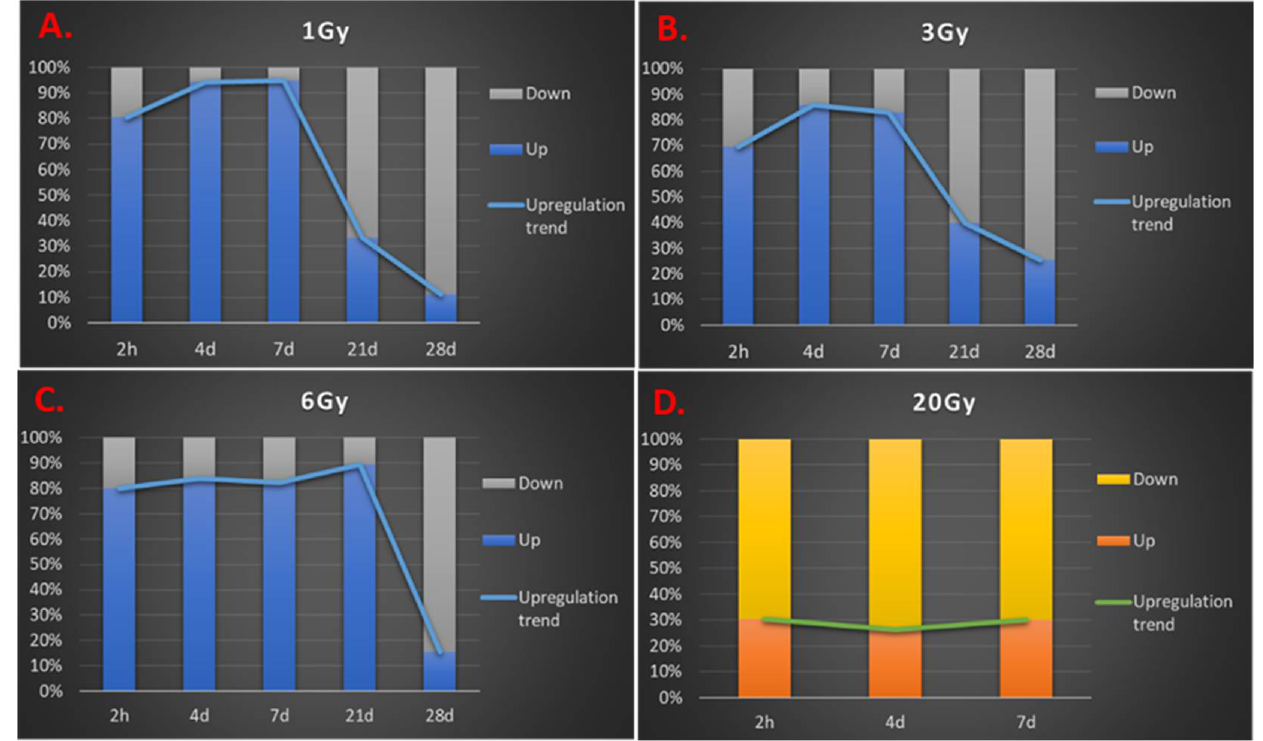
Figure 7. Transcriptional regulation in skin biopsies from mice exposed to different IR doses expressed as ratios of up- and downregulation percentages. Note the inverse relationship of transcription regulation in BLDs and BSDs and shifts of response peaks to later time points by increasing doses of radiation among BSDs. ( A – D ) exposed to 1, 3, 6 and 20 Gy, respectively.